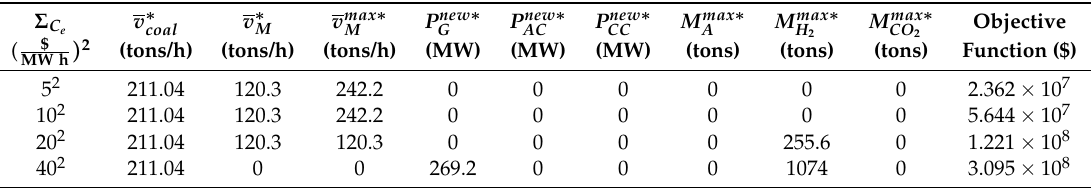
Table 6. Optimal design results as a function of electricity price variance.